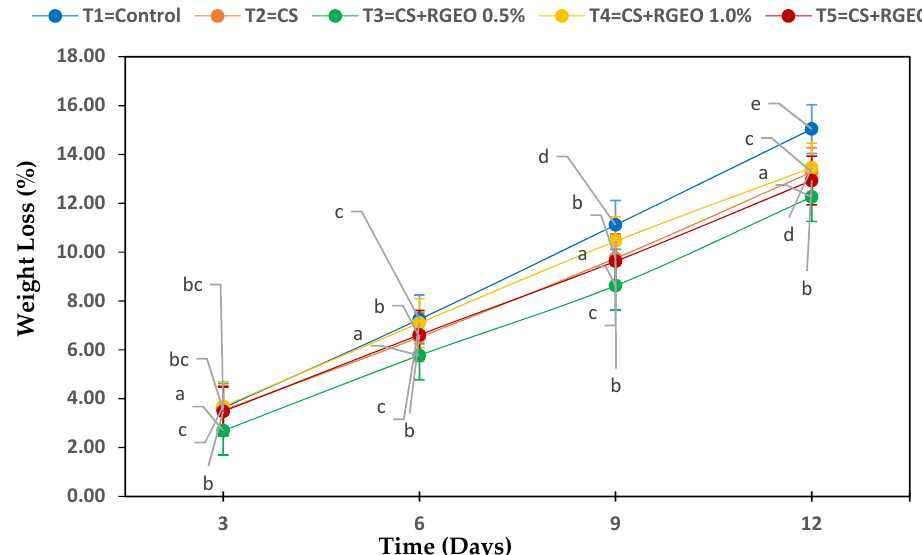
Figure 2. The behavior of the weight loss percentage during the 12 days of evaluation in cape gooseberries coated with the treatments. Note: The superscript letter (a–d) refers to the significant differences ( p < 0.05) between each treatment.